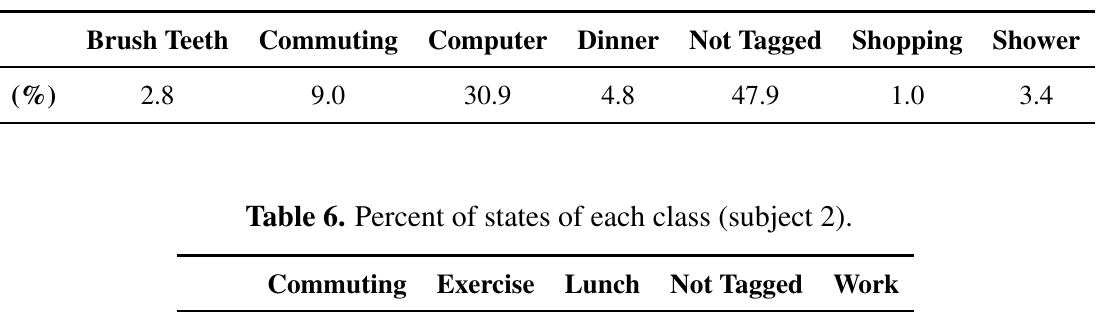
Table 5. Percent of states of each class (subject 1).